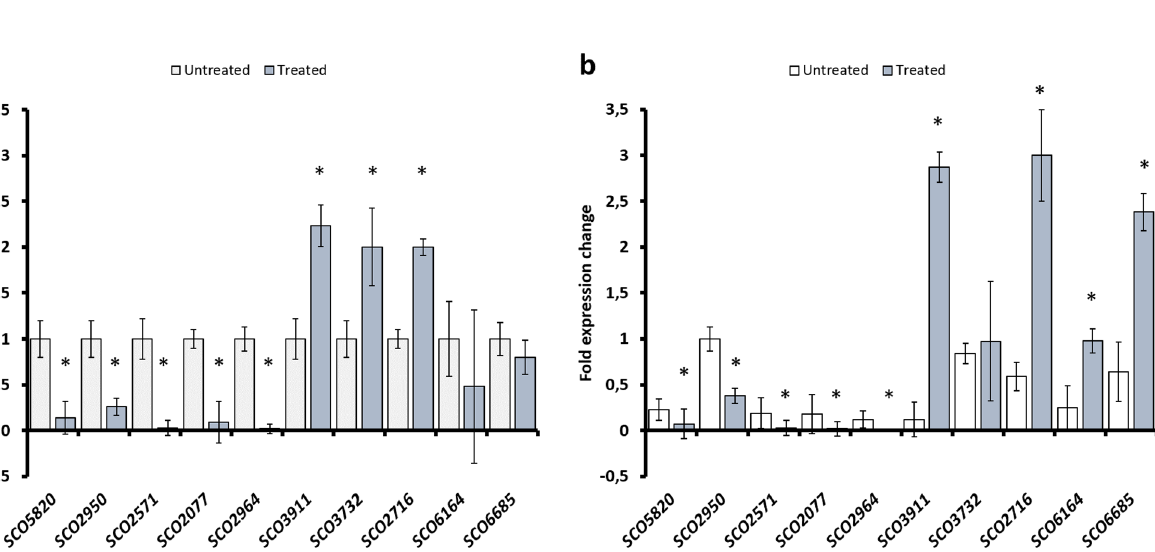
Table 1. List of the genes containing methylated cytosines in their upstream region chosen for RT-qPCR analysis.